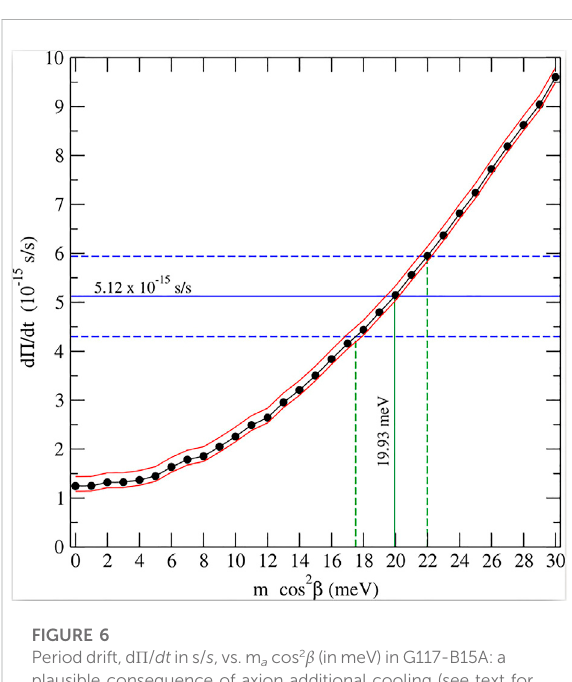
FIGURE 6 Perioddrift,d Π / dt ins/ s ,vs.m a cos 2 β (inmeV)inG117-B15A:a plausible consequence of axion additional cooling (see text for details. Taken from Kepler et al.